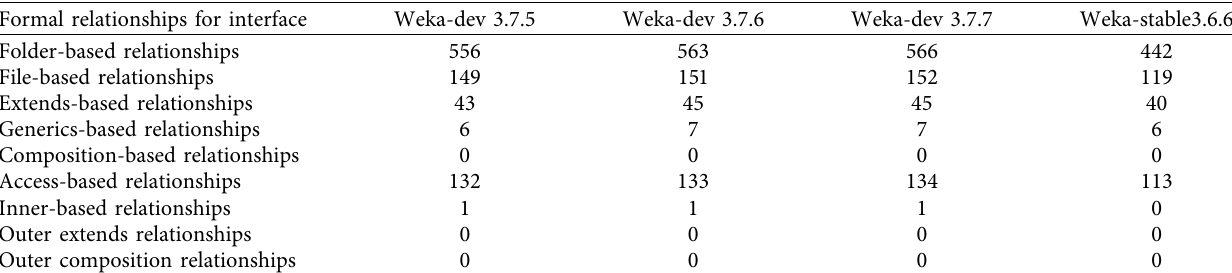
Table 25: Formal relationships for interface in weka.